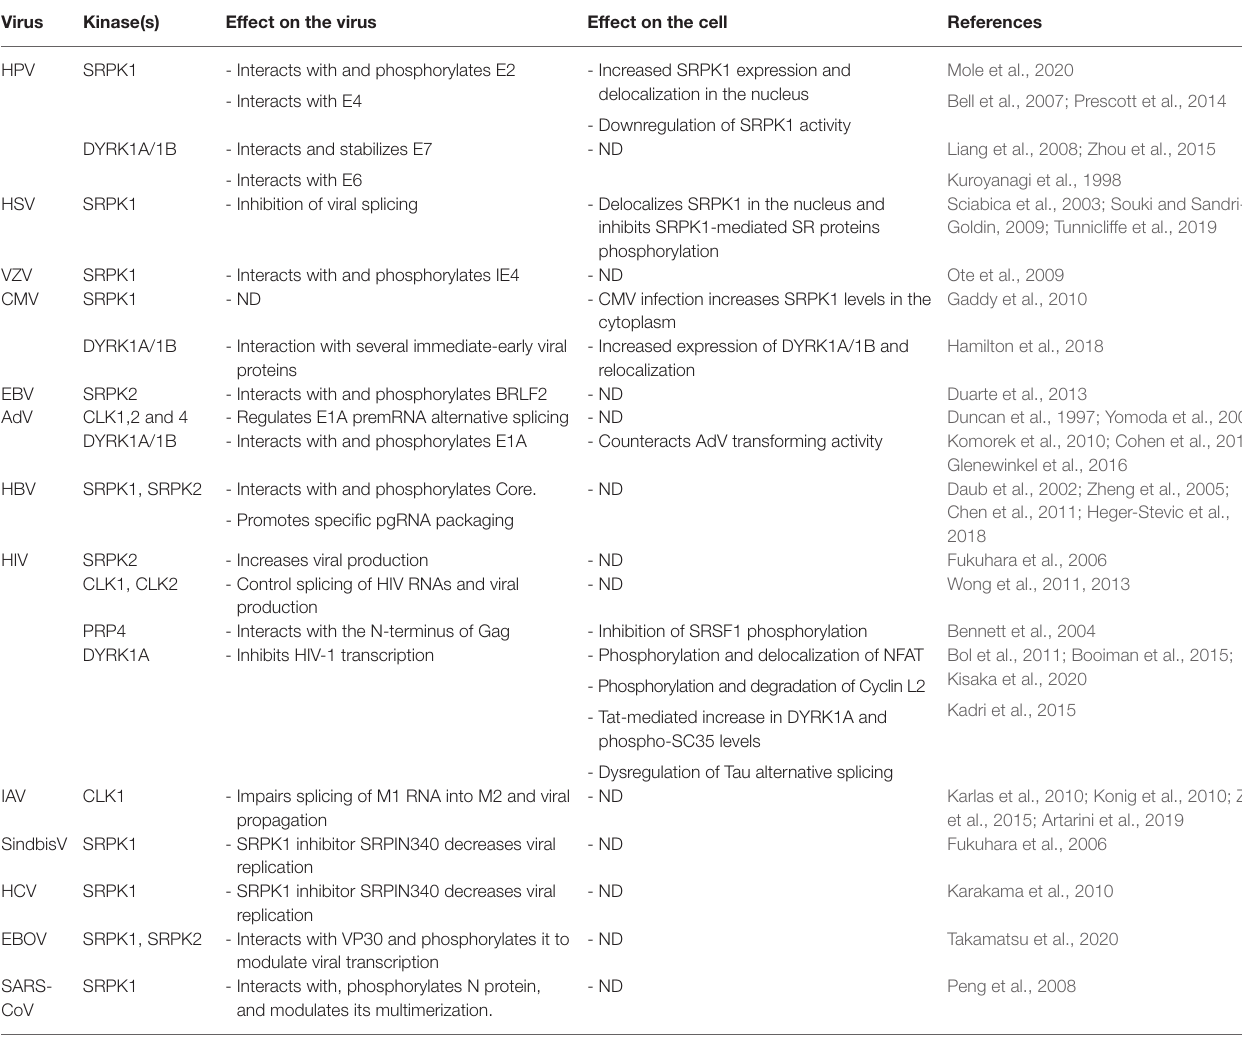
TABLE 1 | Interactions between viruses and kinases that target SR proteins: consequences on viral replication and cell’s functions. Virus